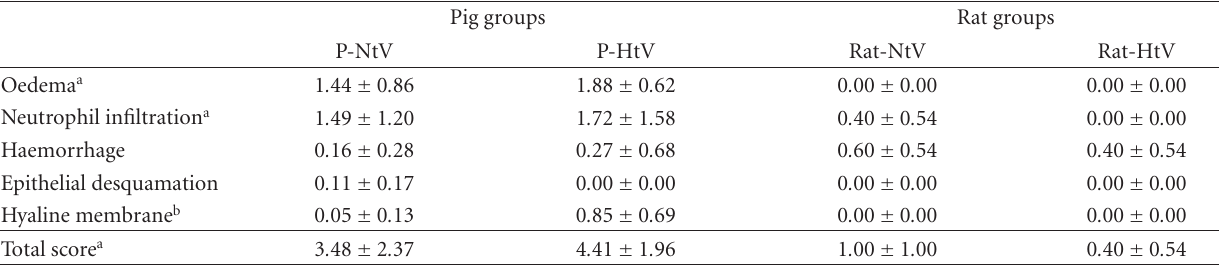
Table 1: Histological score.